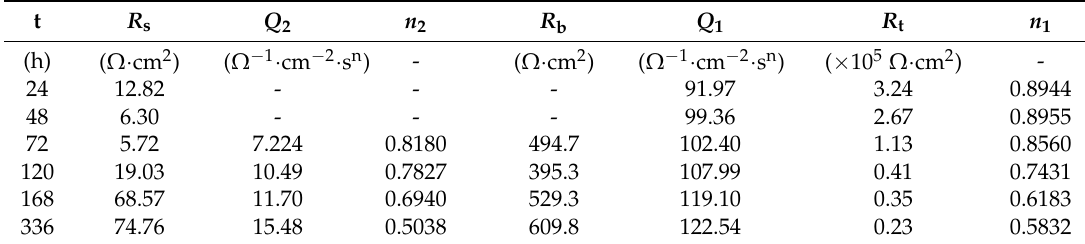
Table 1. Analysis of electrochemical impedance spectroscopy (EIS) for titanium in enriched artificial saliva with S. sanguis at 37 ◦ C for different exposure